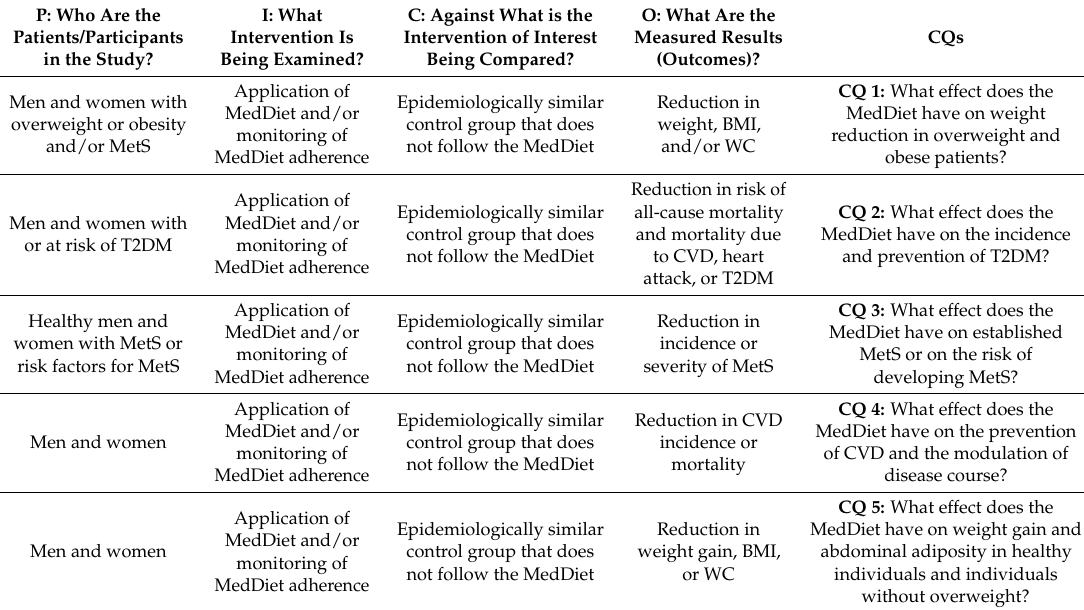
Table 1. Clinical questions (CQs) based on the Patient, Intervention, Comparison, and Outcome (PICO)